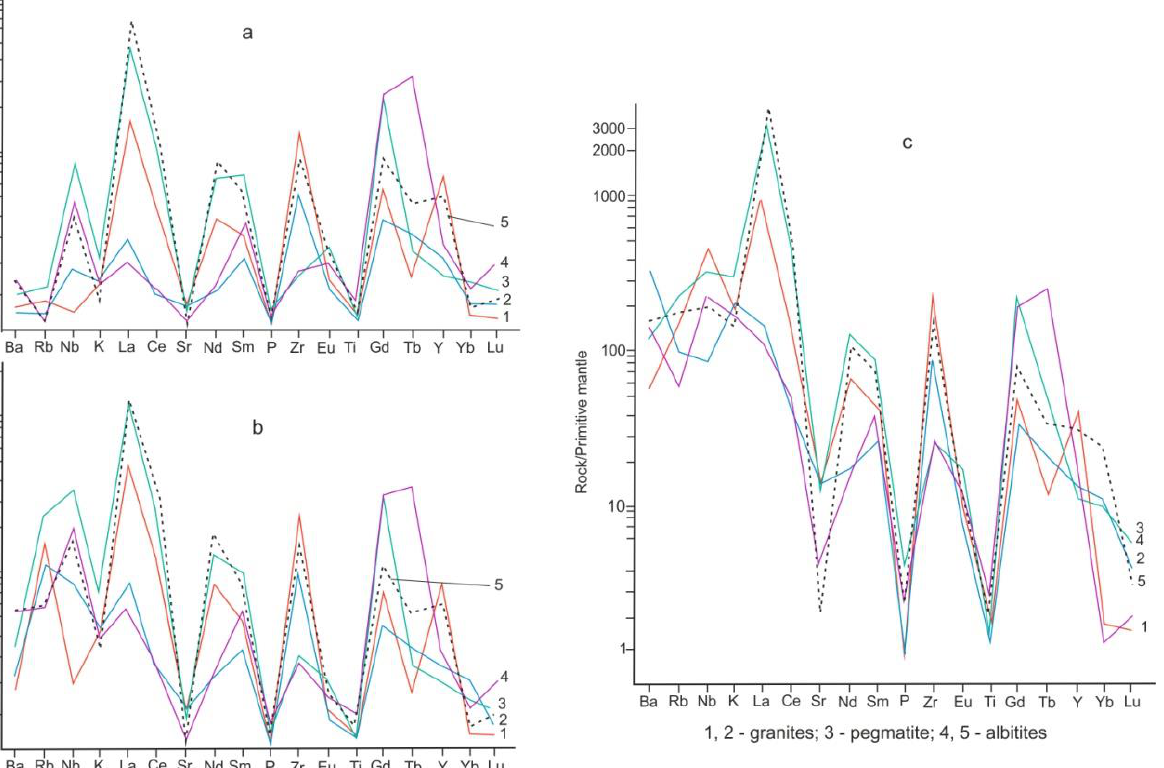
Figure 23. Upper crust- ( a ), lower crust- ( b ), and primitive mantle-normalized ( c ) [77] trace-element patterns for the rocks of the Somnitelnyi massif and Tommot deposit.